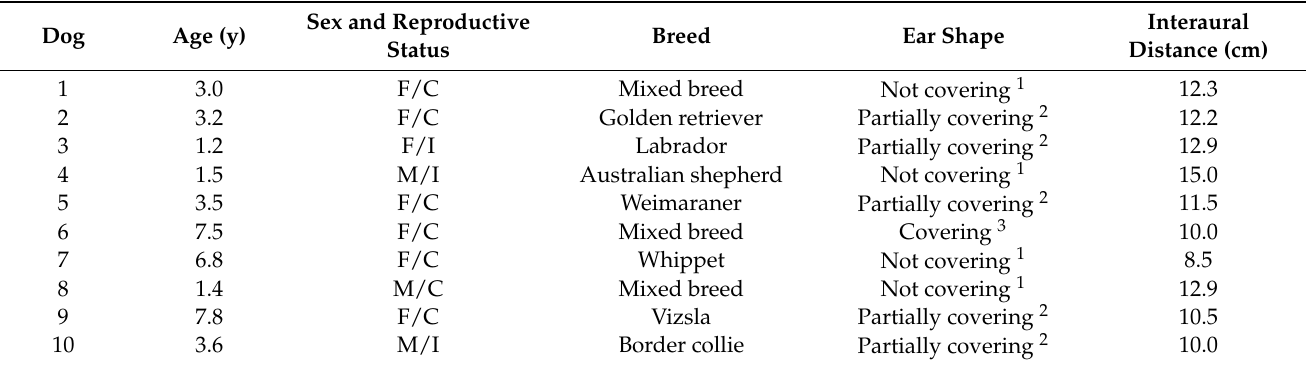
Table 1. Demographics, ear shape and interaural distance of